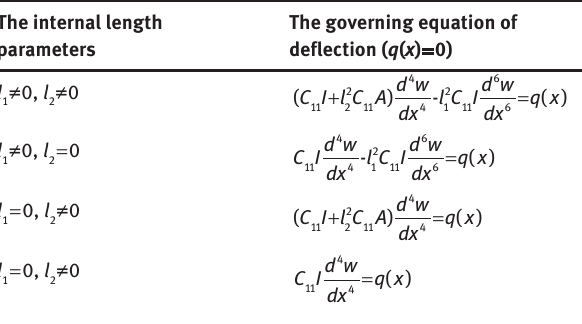
Table 1: Governing equations of deflection with different choice of the internal length parameters.